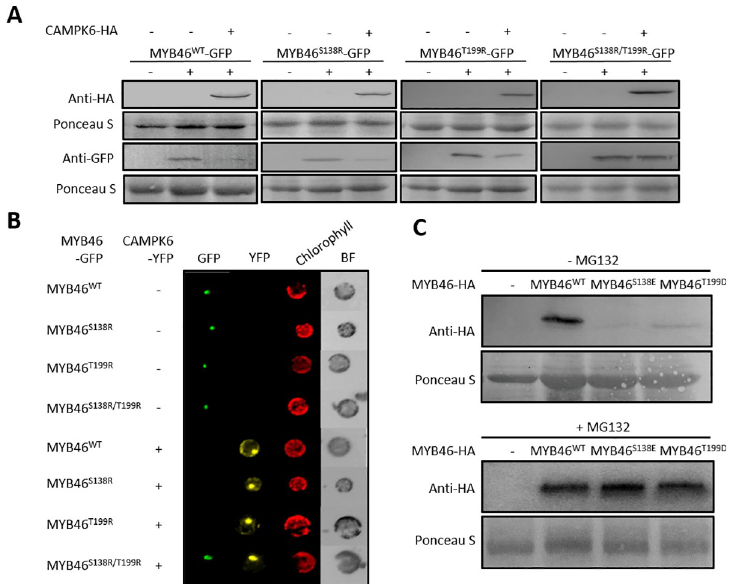
Fig 4. Functional significance of MPK6 phosphorylation target sites of MYB46. (A) Protein blot analysis of MYB46 and its non-phosphorable mutants. The MYB46-GFP and its non-phosphorable mutants (MYB46 S138R -GFP, MYB46 T199R -GFP, or MYB46 S138R/T199R -GFP) were expressed with or without CAMPK6-HA in AMPs and incubated for 10-hr. Protein blot analysis was carried out with anti-GFP antibody for MYB46 and anti-HA antibody for CAMPK6. (B) MYB46-GFP and its non-phosphorable mutants were expressed with CAMPK6-YFP. After 10-hr incubation, image was taken by fluorescence microscopy. (C) From AMPs, protein blot analysis of MYB46-HA and its phospho-mimics (MYB46 S138E or MYB46 T199D ) with or without proteasome inhibitor MG132. The protein blot analysis was carried out with anti-HA antibody.